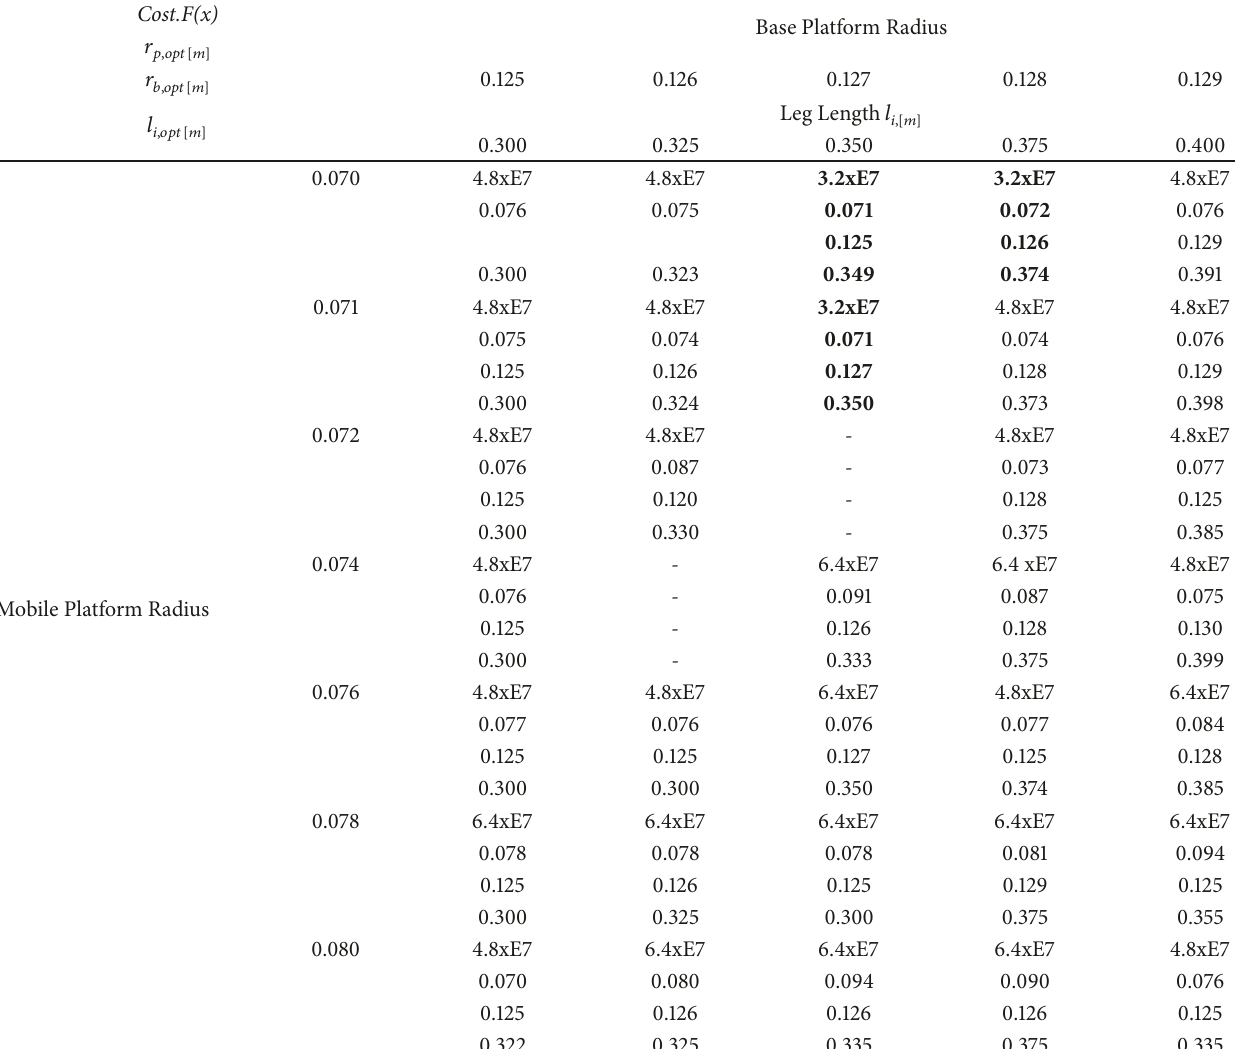
Table 6: Three-variable optimization by narrowing target constraint regions.